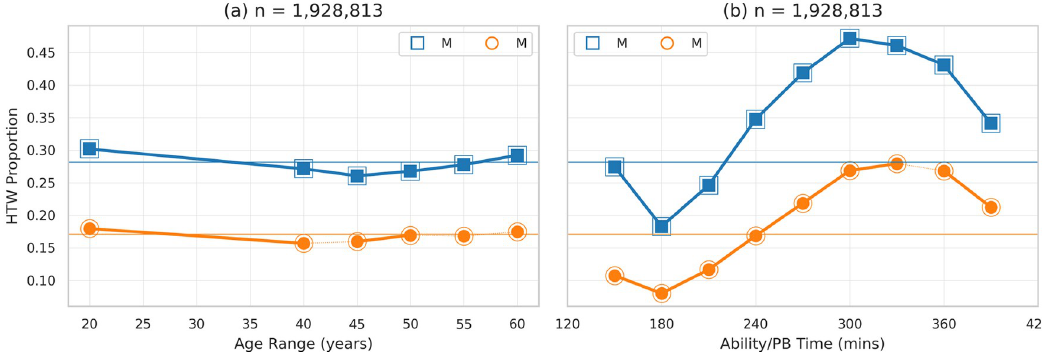
Fig 2. The proportion of male and female runners hitting the wall by (a) age range and (b) ability